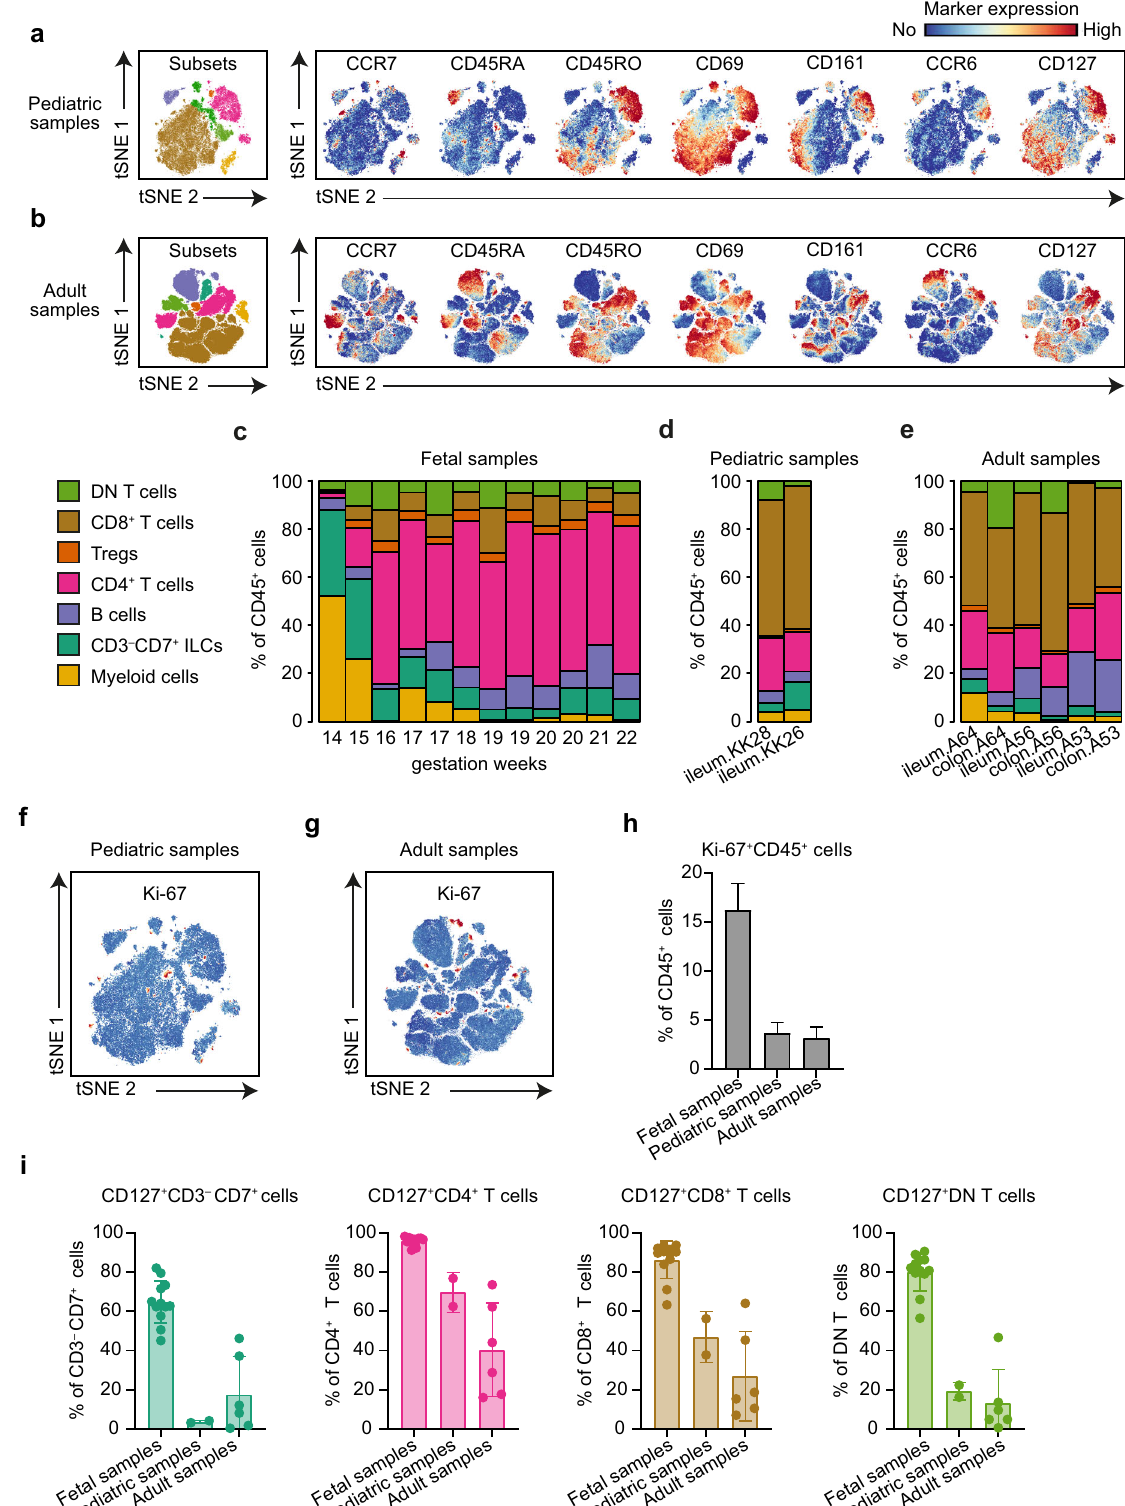
Fig. 3 | Identi fi cation of immune cells composition of pediatric and adult samples. a , b tSNE plots of the data from ( a ) pediatric ( n =2) and ( b ) adult ( n =6) samples, where the major immune subsets are indicated and the expression of selected markers is shown. c – e Percentages of the major immune subsets in the samples analyzed. f – h tSNE plots displaying Ki-67 expression in samples from ( f )